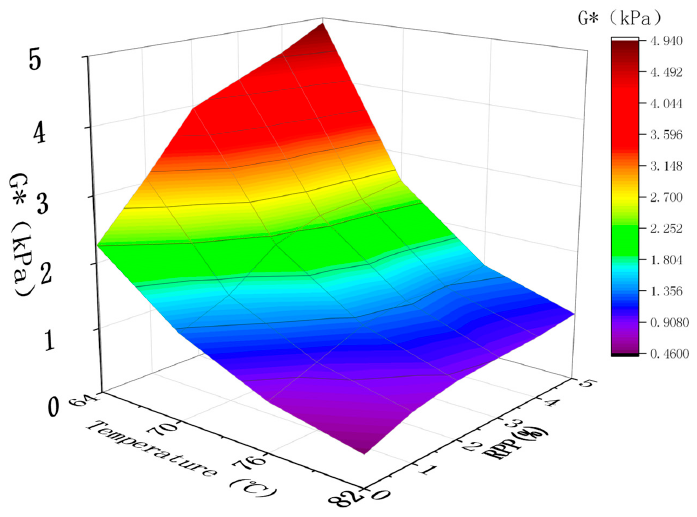
Figure 10. Effect of temperature and RPP content on modified asphalt G*. The composite shear modulus G* represents the ability of the sample to resist defor- mation during repeated shearing. It is the ratio of the maximum shear stress to the maxi- mum shear strain. Figure 10 reveals that, within the test range of 64–82 °C , the G* values